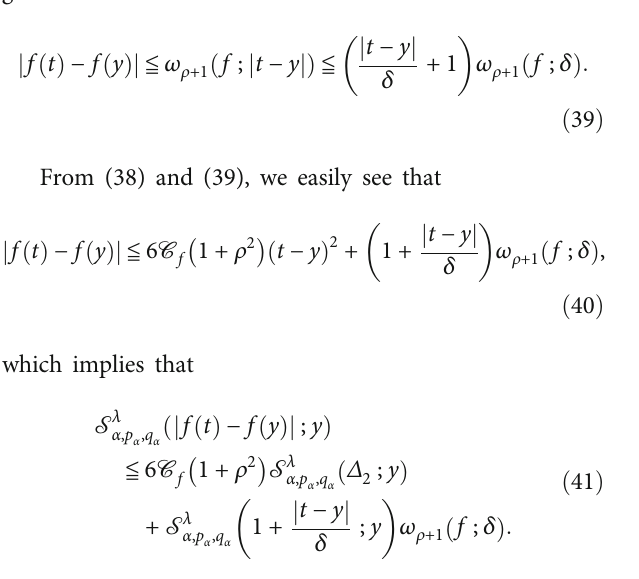
(cid:1) (cid:3)n o ffiffiffi p , ð 46 δ